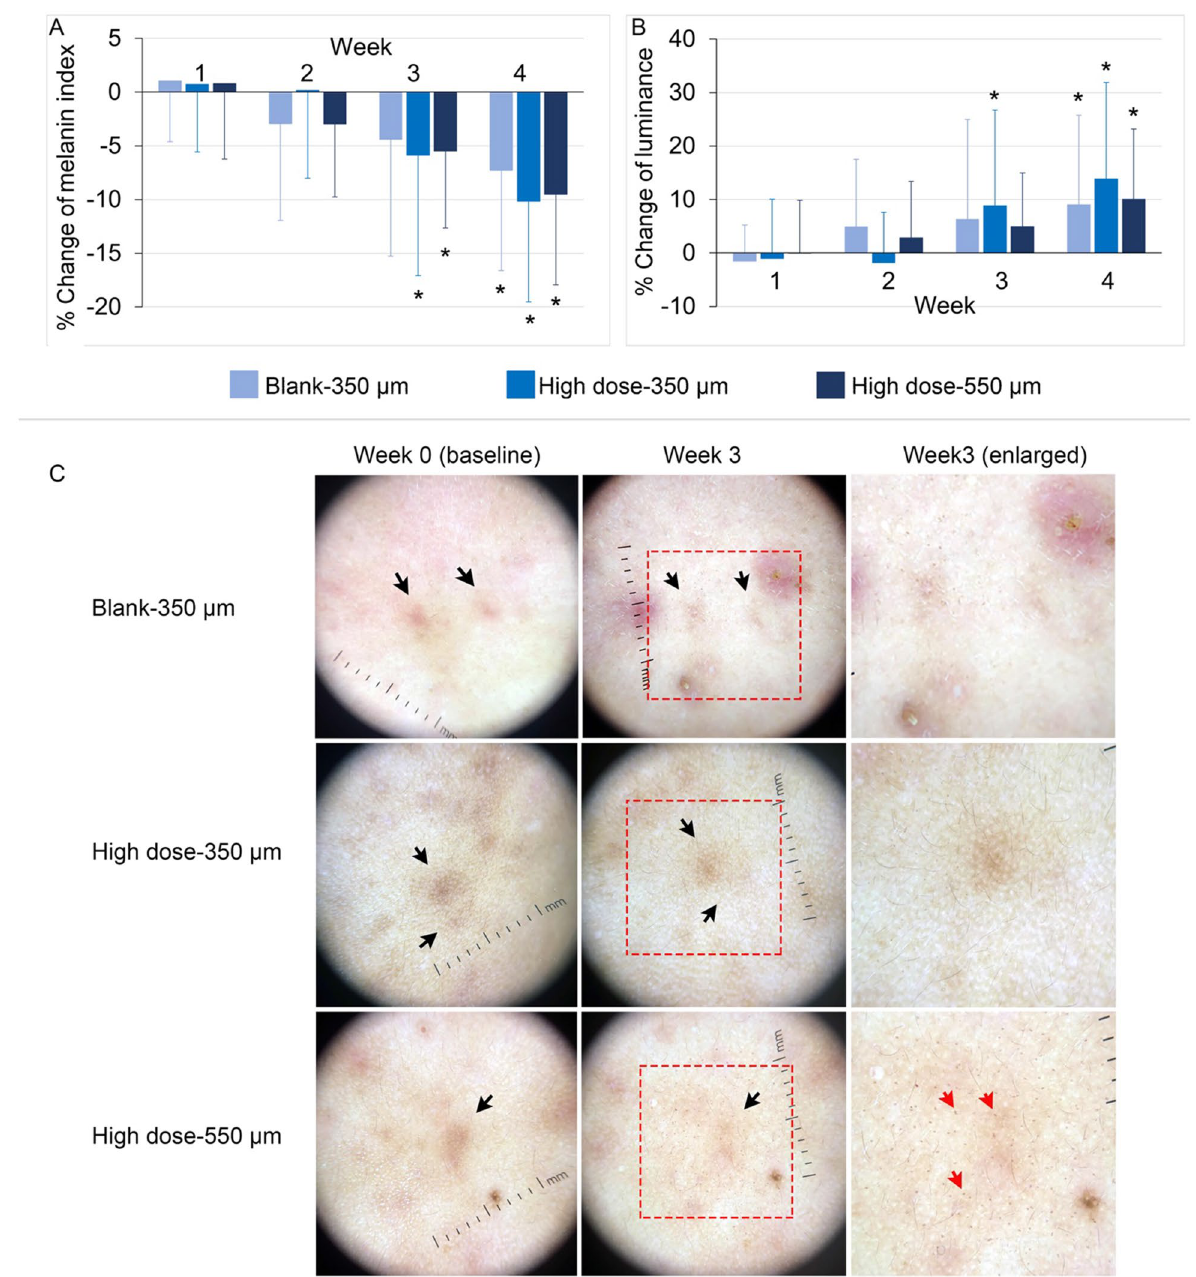
Figure 5. Skin whitening efficacy of vitC-gluta-DDMNs. Skin whitening of the post-acne-hyperpigmentation spots at 1, 2, 3 and 4 weeks after daily uses of the unloaded-DDMNs (Blank-350 µm), high dose-vitC-gluta- 350-DDMNs (High dose-350 µm) and high dose-vitC-gluta-550-DDMNs (High dose-550 µm), is reported as % change of melanin index ( A ) and % change of luminance value L* ( B ) in relative to the original value (before treatment) of the same skin spot of each person. The bar represents the mean value, and the error bar represents standard deviation. Data were analyzed using mixed linear model by STATA software version 14.0 (Stata Corp LLC, USA). Significant difference between each time point and week 0 (baseline) is depicted with *at the p < 0.05. ( C ). Representative pictures of the post-acne-hyperpigmentation spots (black arrows) before the treatment (week 0, left column) and after 3 weeks of daily application of the tested sample (week 3, middle and right columns) are shown in ( C ) for the three tested samples which include unloaded-DDMNs (first row), high dose-vitC-gluta-350-DDMNs (second row) and high dose-vitC-gluta-550-DDMNs (third row). Red arrows point at examples of hyperpigmented spots formed after the microneedle treatment. The red dotted square in the middle column of C indicated the enlarged area shown in the right